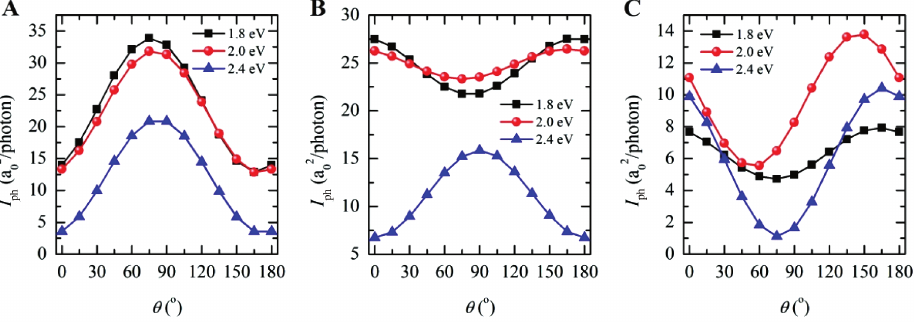
Figure 2: The dependence of photocurrent on polarization angle in bilayer tellurene. The photocurrent as a function of the polarization angle θ in the (A) covalent bond 1-direction, (B) close-packed nonbond 2-direction, and (C) nonbond 3-direction of bilayer tellurene for the photon energies of 1.8, 2.0, and 2.4 eV at 0.2 V. The lines are the fitted